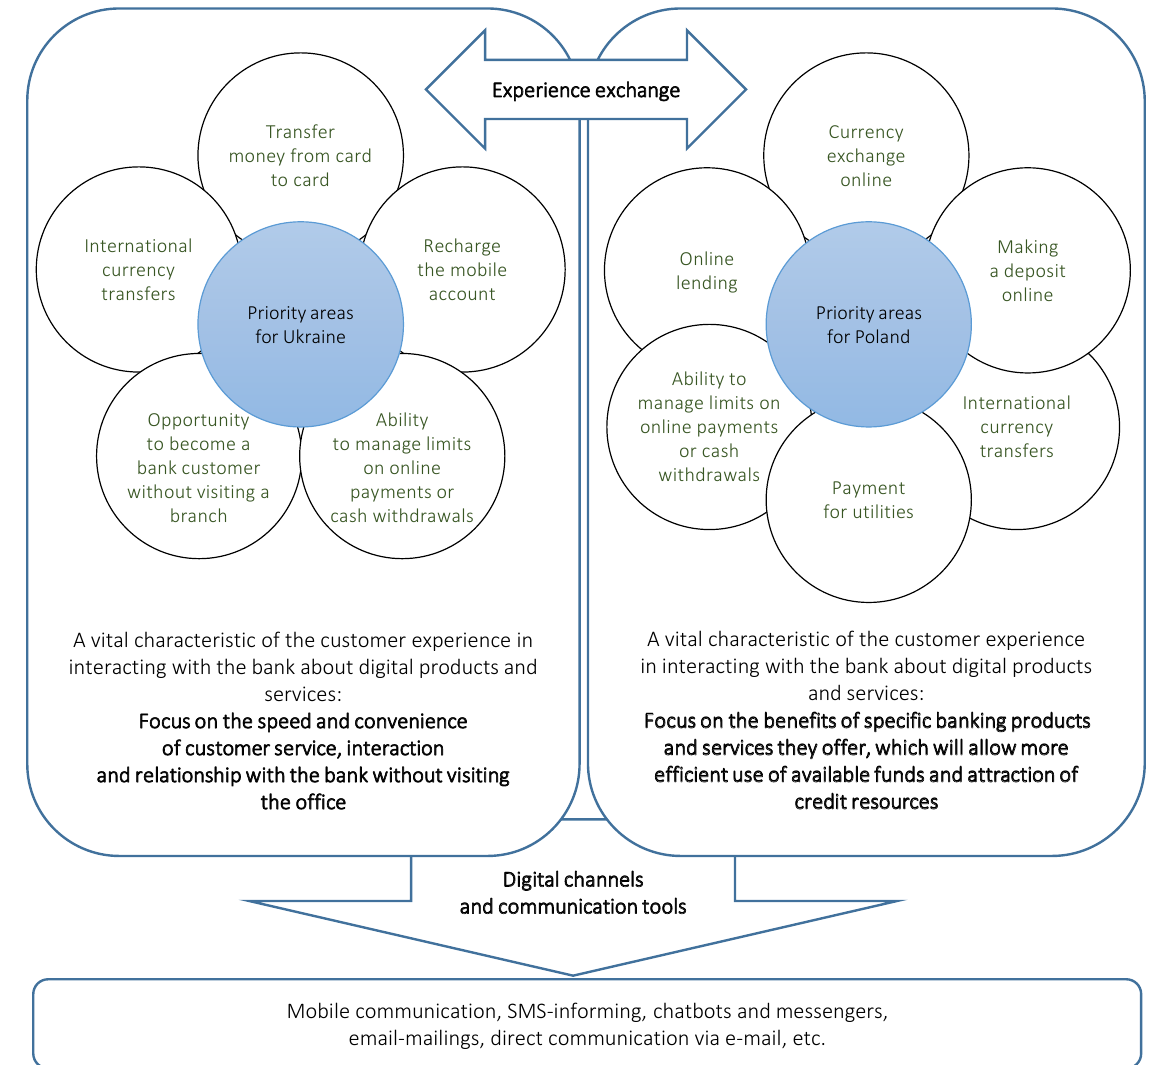
Figure 5. Priority areas for improving the efficiency of digitalization of customer relations in the Ukrainian banking sector (compared to the Polish experience and development